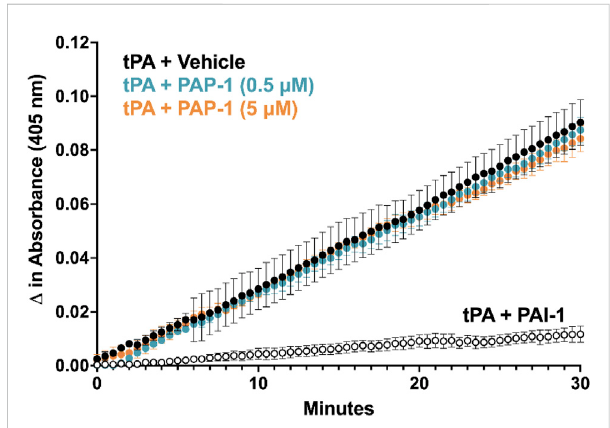
FIGURE 5 PAP-1doesnotinterferewithtPAactivity invitro .PAP-1at0.5 μ M and 5 μ M does not inhibit tPA activity as measured by increases in absorbance at 405 nm of a chromogenic tPA substrate. Each data point shown is the average of three independent experimental runs ±S.E.M. Each reaction was performed in triplicate